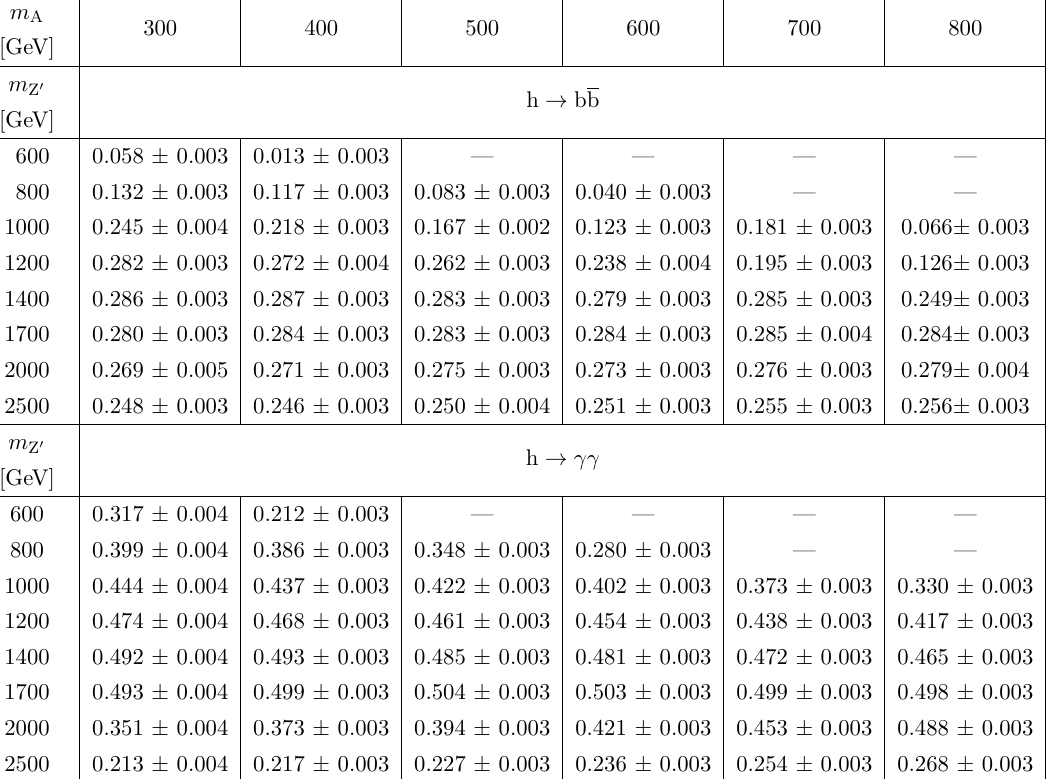
Table 1 . The product of acceptance and e(cid:14)ciency (with statistical uncertainty) for signal in the SR, after full event selection for the h ! bb (upper) and the h ! (cid:13)(cid:13) (lower) decay channels. The systematic uncertainty for h ! bb (h ! (cid:13)(cid:13) ) is approximately 10% (5%). For h ! bb, the value shown here is either for the resolved regime or for the boosted regime, depending on which is